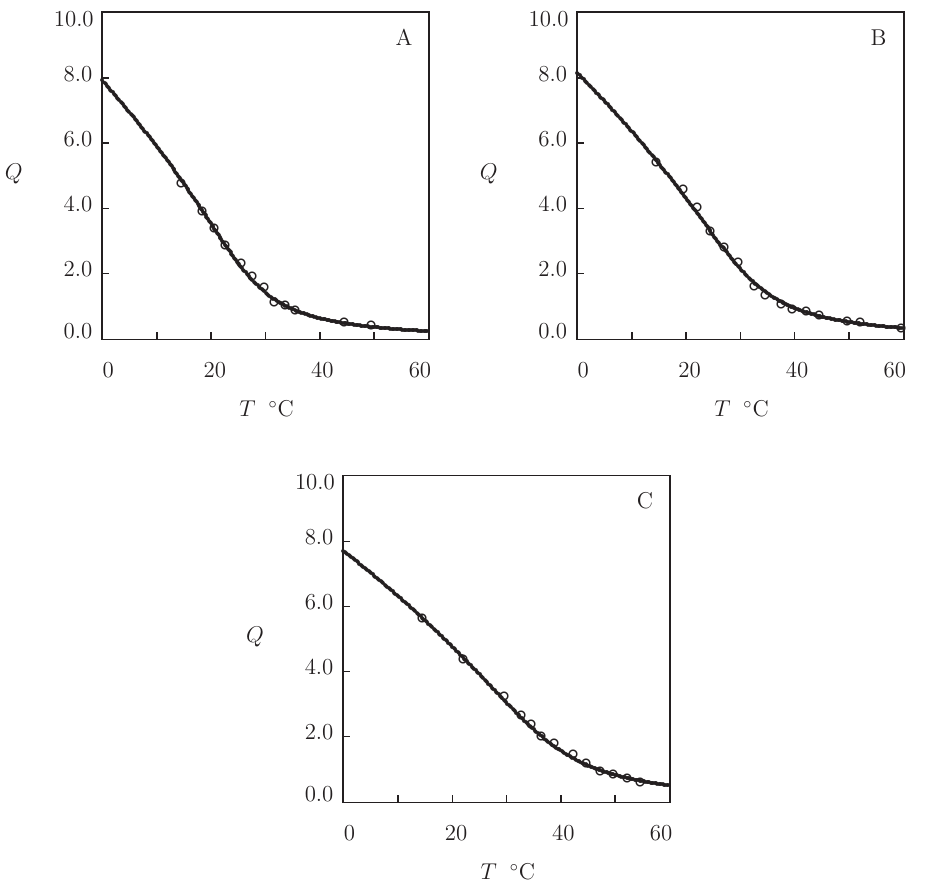
Figure 15. Degree of swelling Q versus temperature T . Circles: experimental data [108] on P(MEO 2 MA-OEGMA 500 ) microgels with various molar fractions ψ of OEGMA monomers (( A ) ψ = 0.05, ( B ) ψ = 0.17, and ( C ) ψ = 0.26). Solid lines: results of